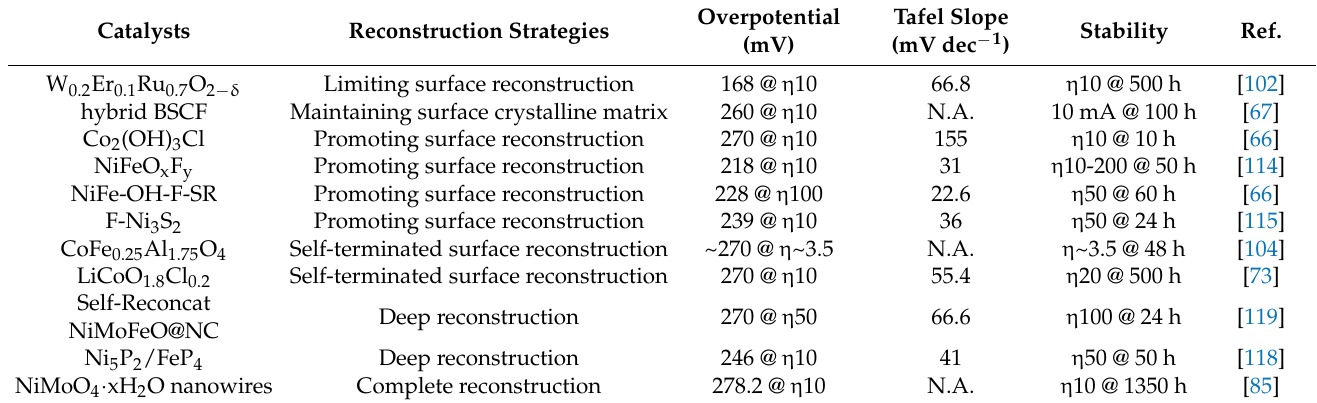
Table 1. Summary of OER performance of discussed catalysts in the main